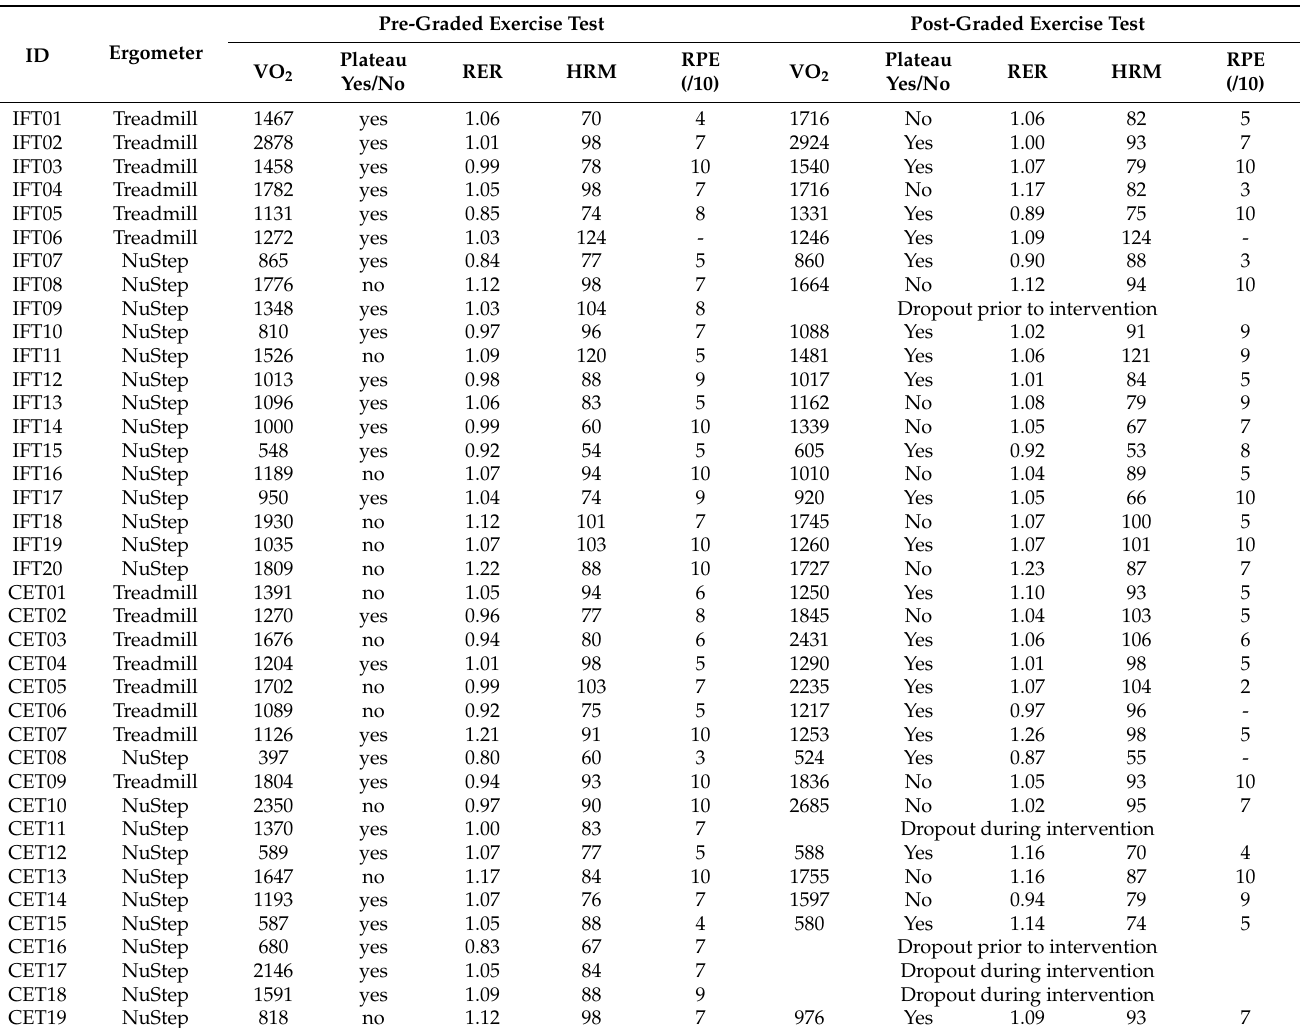
Figure 3. Change in maximum oxygen uptake (VO 2max ) over the 10-week intervention period among participants randomized to ( a ) intermittent functional training and ( b ) constant-load ergometer training. Dotted lines indicate the a priori threshold for change in VO 2max (i.e., 1.4 mL min − 1 kg − 1 ). Solid lines display the mean difference and 95% confidence interval. Table 2. Participants Maximum Absolute Oxygen Uptake and Achievement of Graded Exercise Testing Criteria at Pre and Post Assessments.